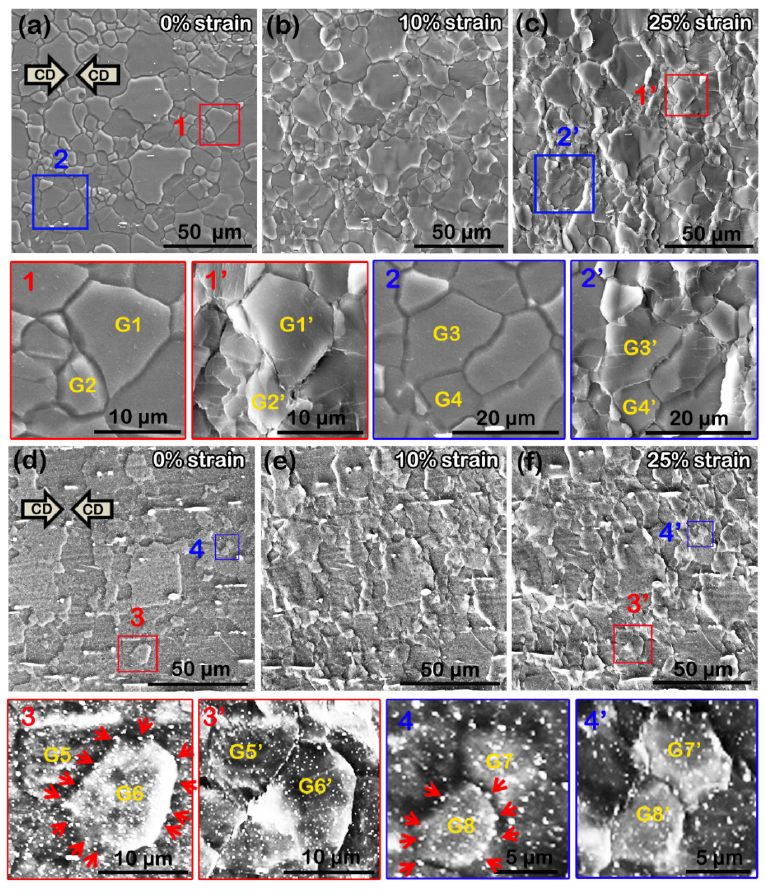
Figure 11. Quasi in situ SEM images of two as-extruded alloys subjected to hot compression at different strains: 0, 10, and 25% strains for ( a – c ) as-extruded AZ31 alloy and ( d – f ) as-extruded AZB313 alloy, respectively. Table 1. Maximum width (along CD) and height (perpendicular to CD) of G1-G8 grains marked in Figure 11 after hot compressive strain of 0 and 25% at 523 K. Unit: µ